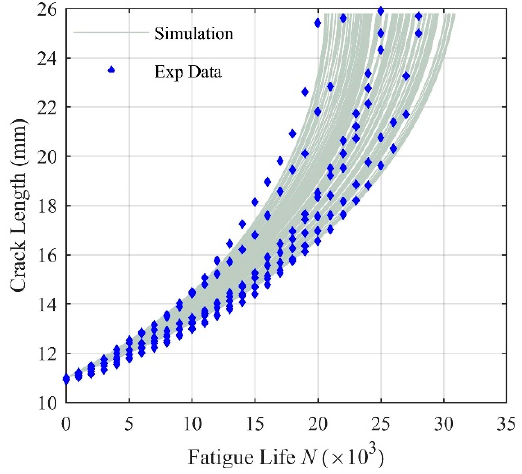
Figure 5. Crack length under constant amplitude